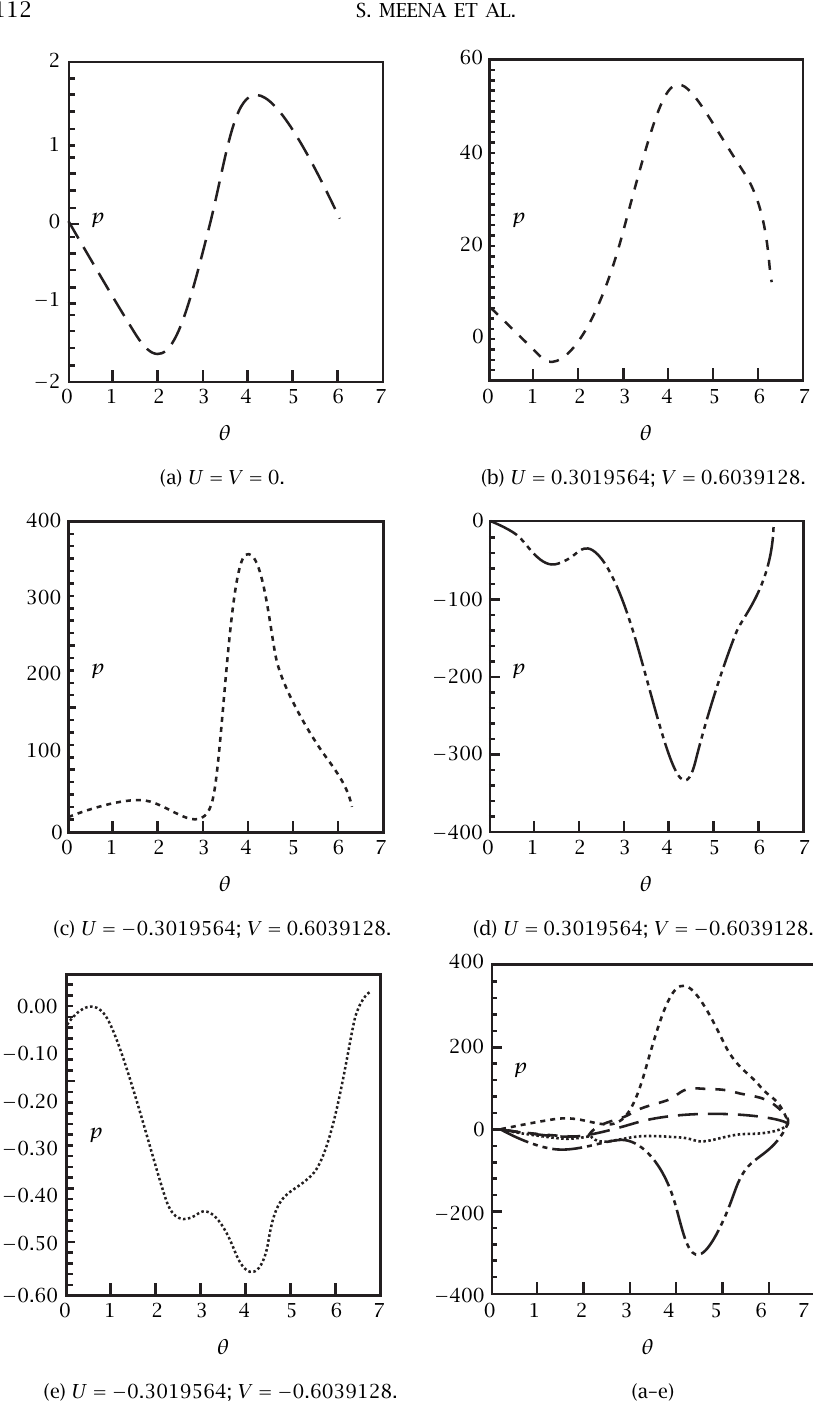
(e) U = − 0 . 3019564; V = − 0 . Figure 24 . The pressure distribution for (cid:9) = 0 . 5; η = − 1 . 0; R M = 0 . 01; α = 0 .